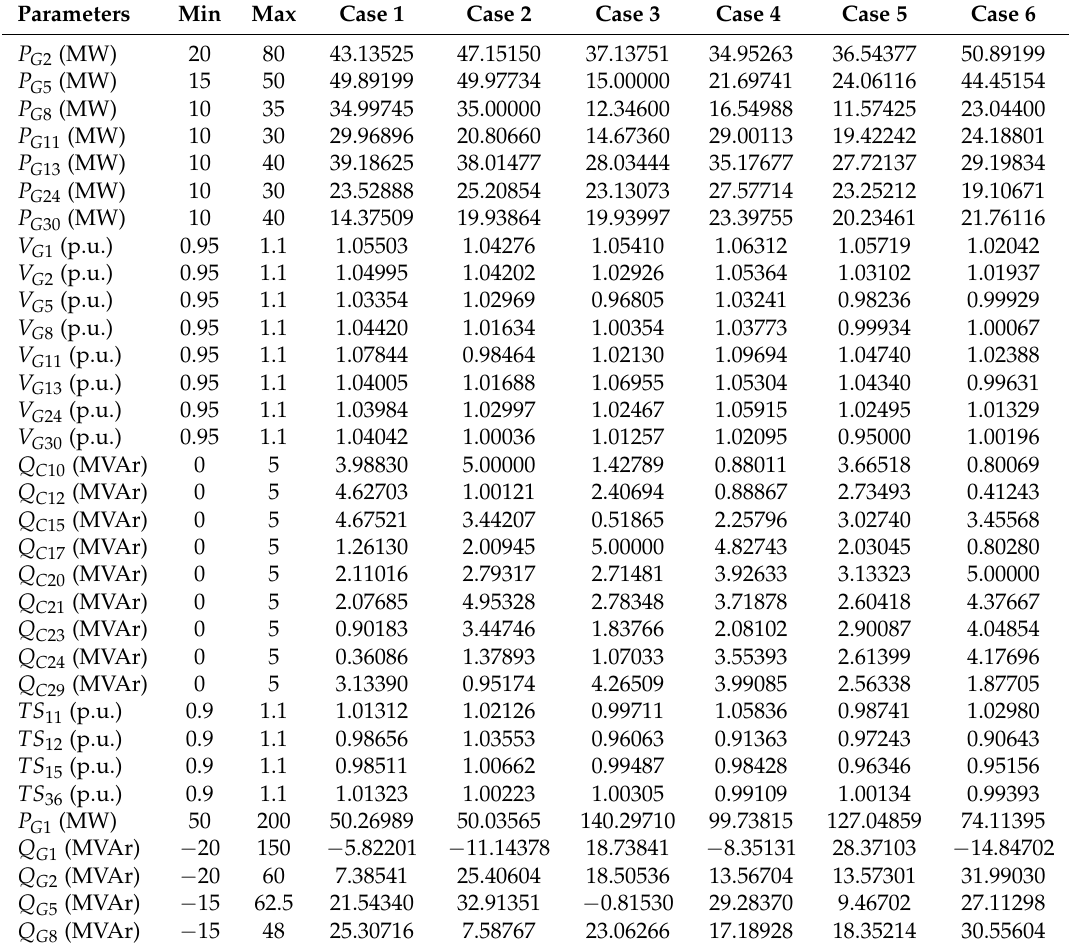
Table A9. Optimal solution obtained by GROM for single-objective OPF for IEEE 30-bus Modified (1).